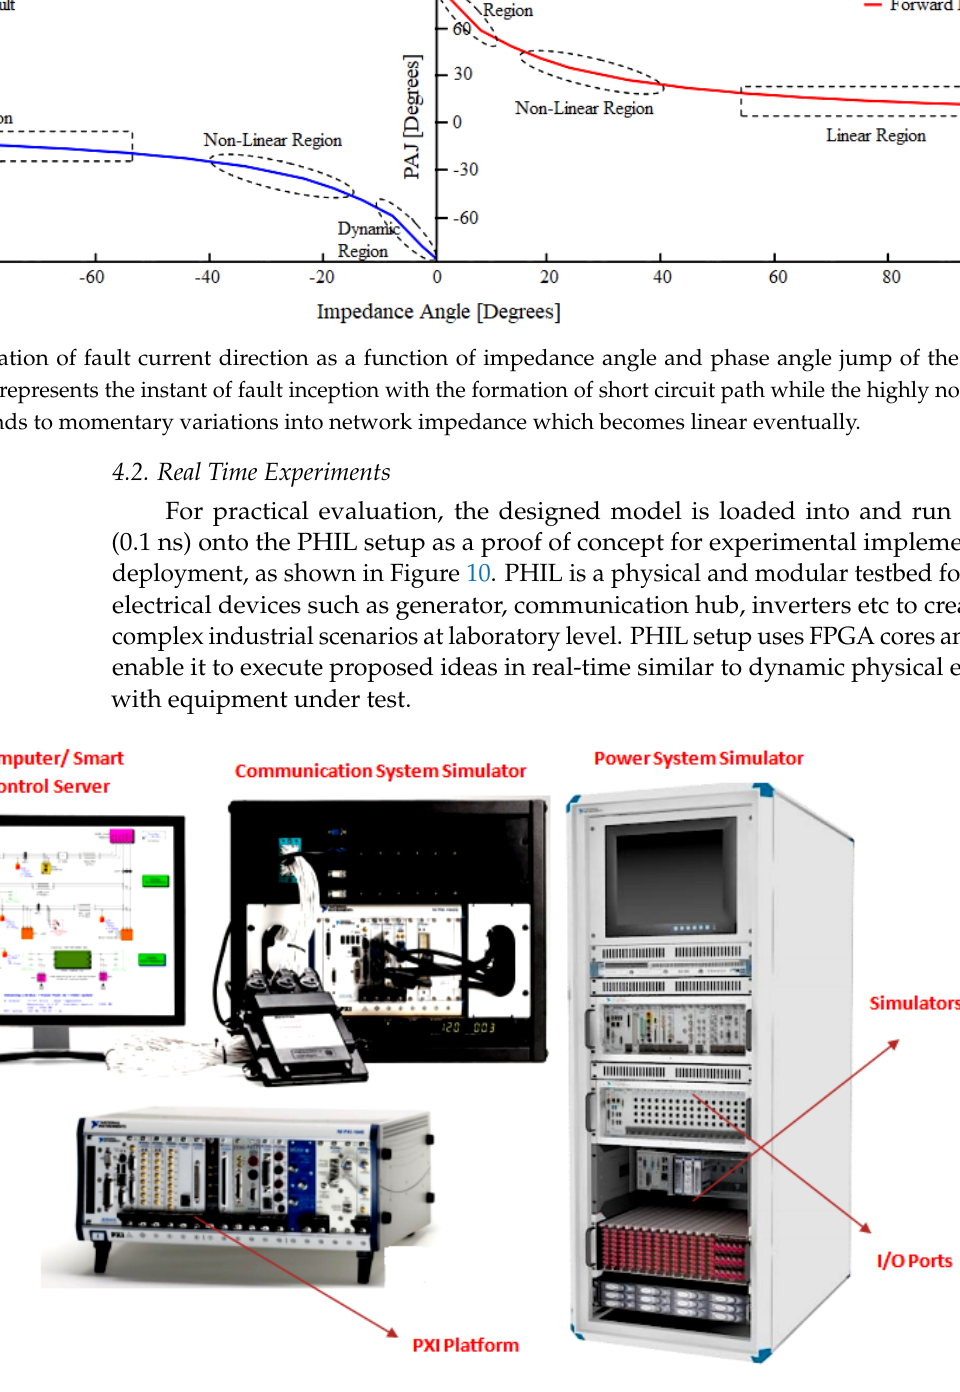
Figure 10. PHIL system architecture on real-time evaluation of proposed protection coordination approach in smart grid